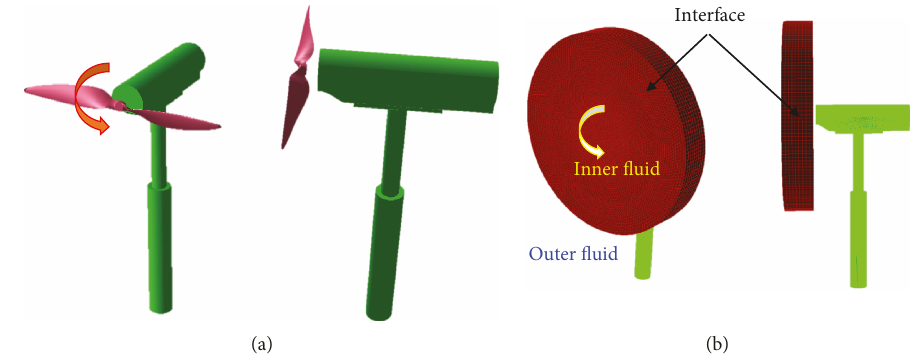
Figure 20: Comparison of CFD results with (a) design code and (b) wind tunnel test.